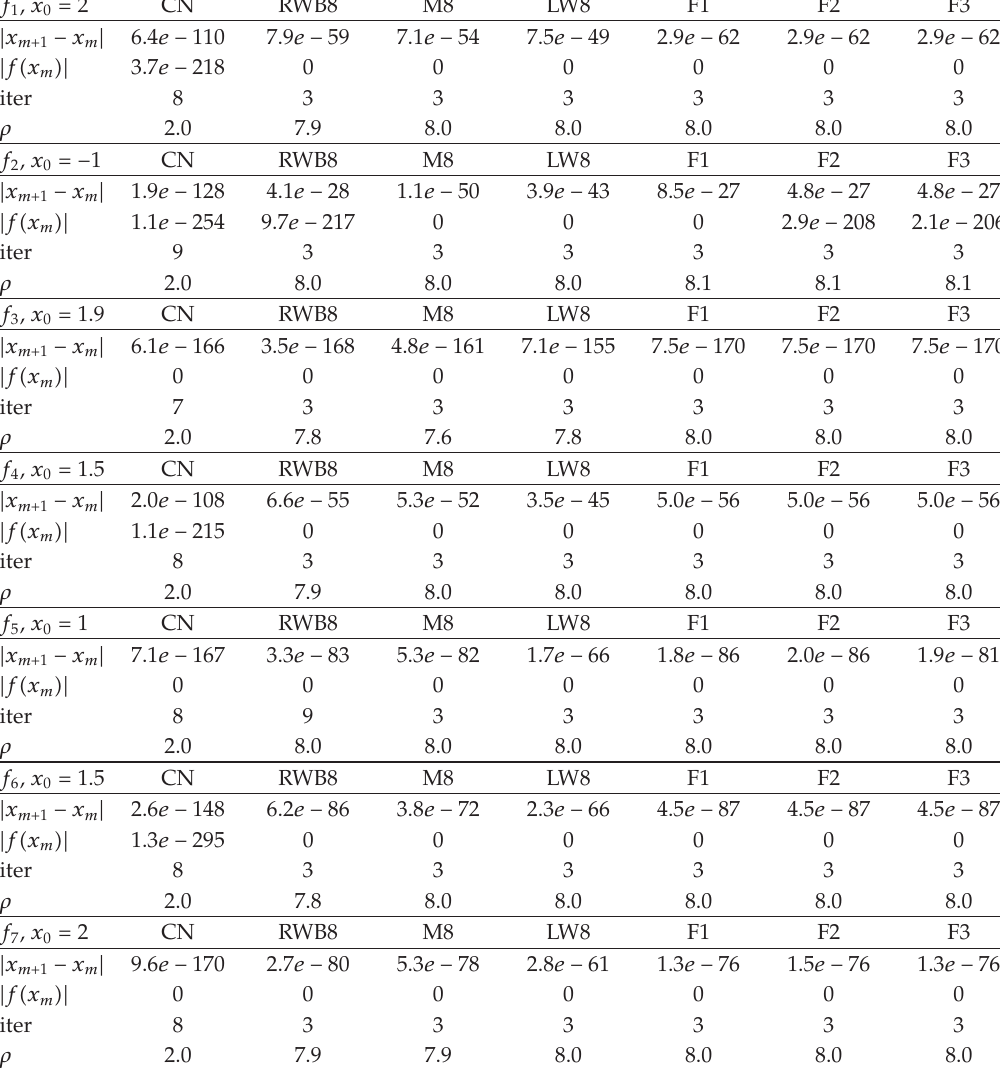
Table 1: Comparison of various iterative